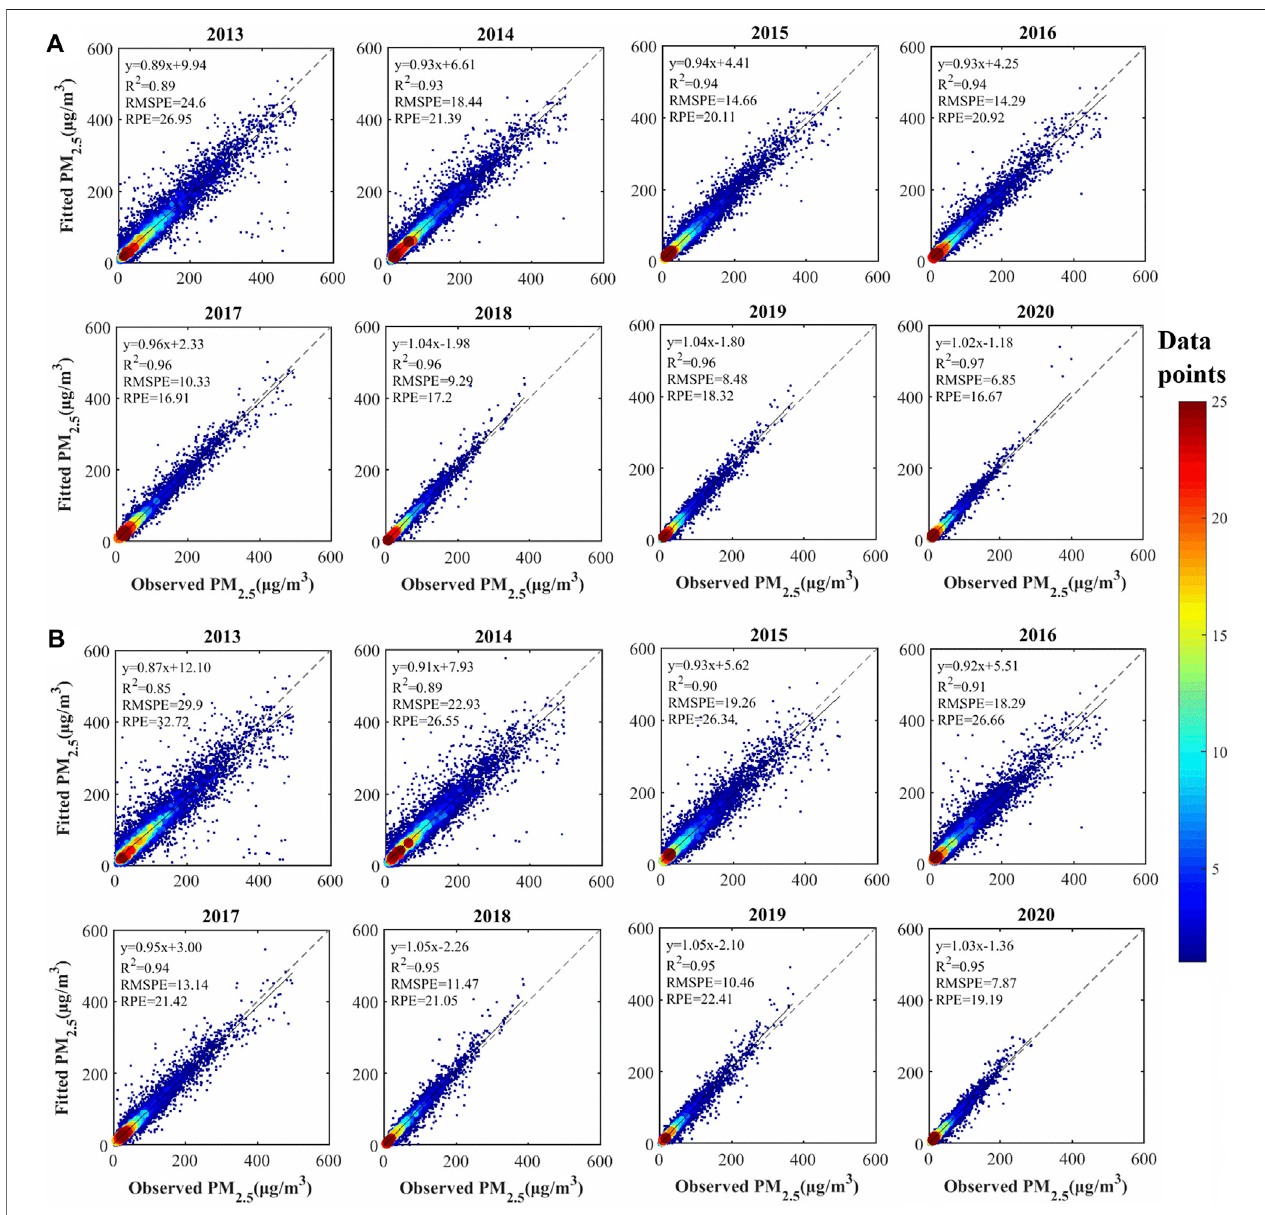
FIGURE 4 | Comparison of model fi tting (A) and 10-fold cross-validation (B) results from 2013 to 2020.